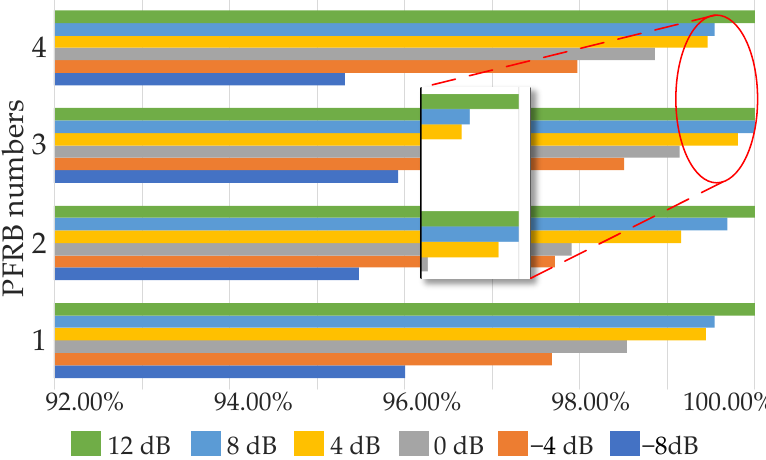
Figure 8. The accuracy of the BayesianPDL framework tested under different numbers of PFRBs. As the SNR gradually increases, the accuracy of the BayesianPDL framework is getting higher. As the number of PFRBs increase, the accuracy of the proposed method also increases. When the number of PFRBs is 3, the accuracy of fault diagnosis reaches the